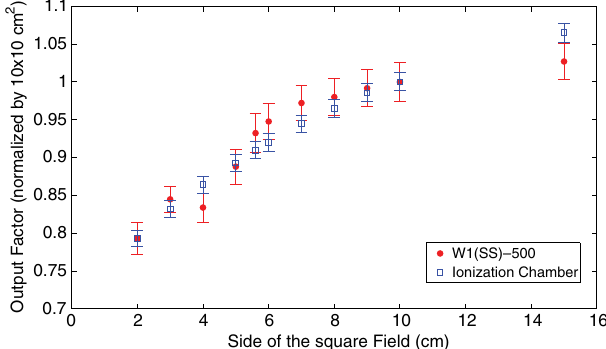
FIG. 9. Output factor measured with different square fields in the slab phantom.